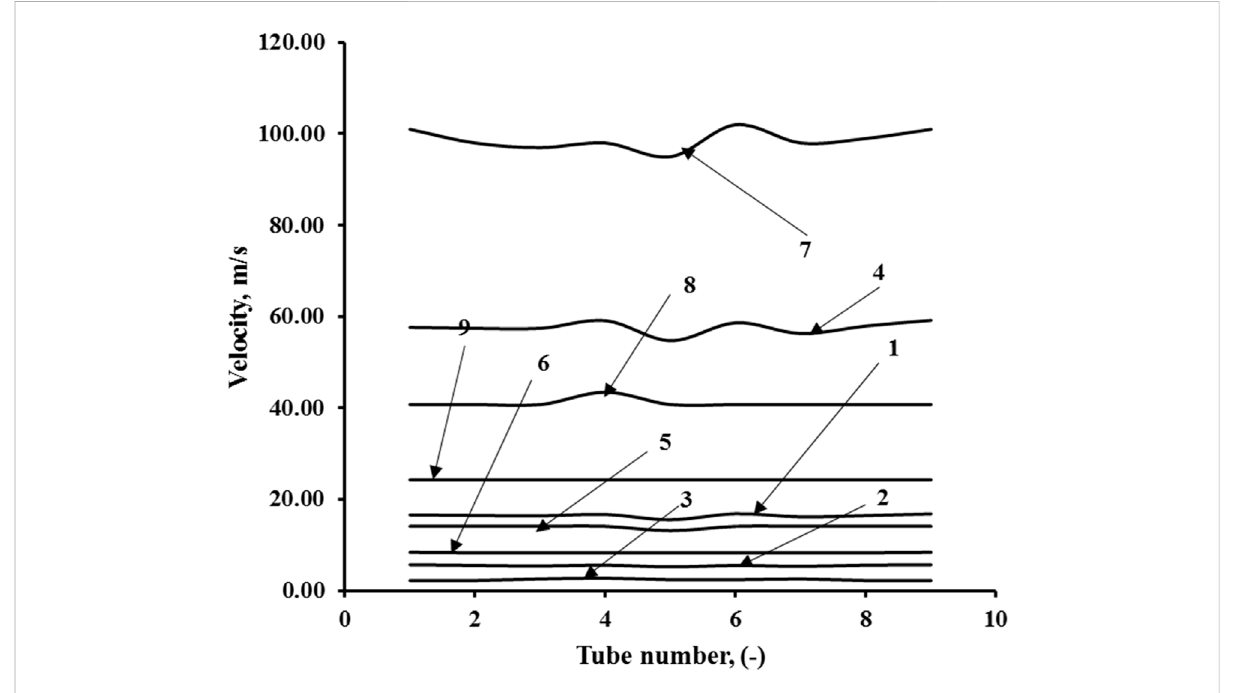
FIGURE 10 Velocity pro fi lesafter installation ofdistributorsfordifferentReynoldsnumbersatdifferentpressures.Re=2.82E+05: 1)10bar,2)40bar,and3) 70 bar; Re = 9.86E+05: 4) 10 bar, 5) 40 bar, and 6) 70 bar; Re = 1.91E+06: 7) 10 bar; Re = 2.82E+06: 8) 40 bar and 9) 70